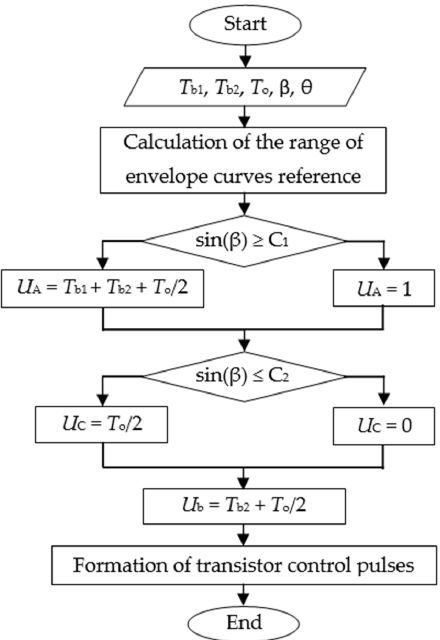
Figure 2. The flowchart of modification algorithm of envelope curve inside sector 1.